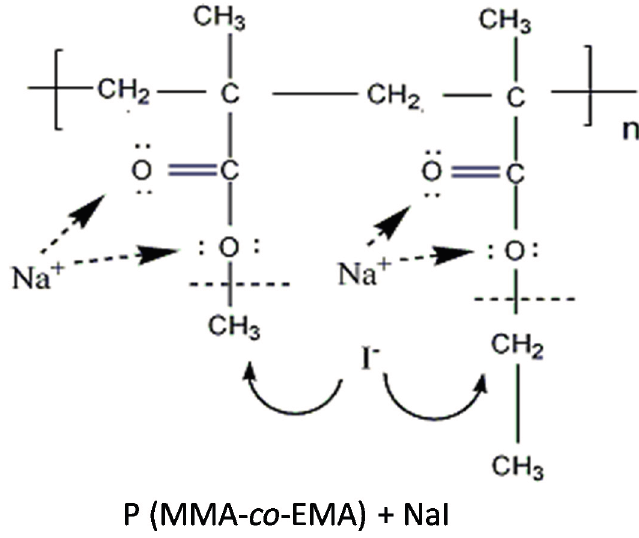
Figure 2. Possible mechanism of P(MMA- co -EMA) + NaI polymer